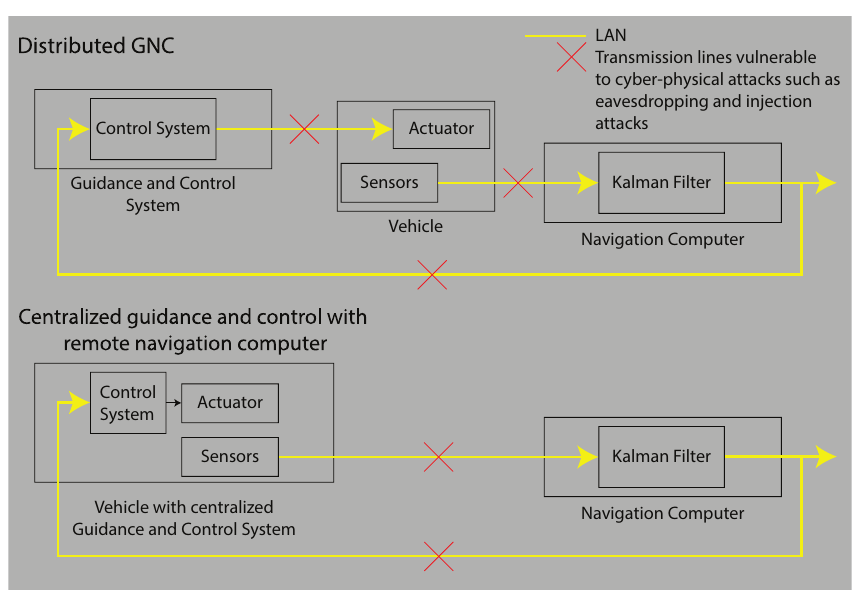
Figure 2: A generic schematic of the signal flow in vehicles with a distributed GNC architecture and a centralized guidance and control computer with a remote navigation computer. Surfaces that are vulnerable to attacks are marked, and the goal is to make the system resistant against attacks on these